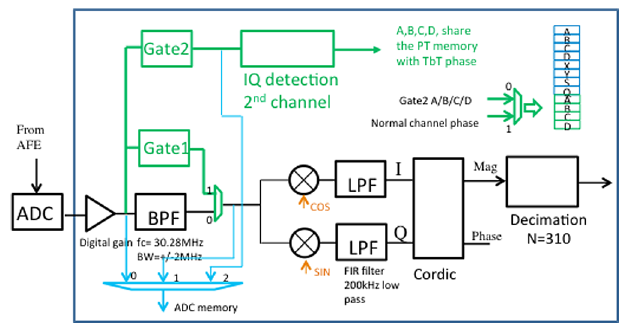
FIG. 4. The schematic diagram of the gated signal processing. Two signal-processing channels with separated gates are pro- vided. One of them (Gate 2) is dedicated to processing the DBT.